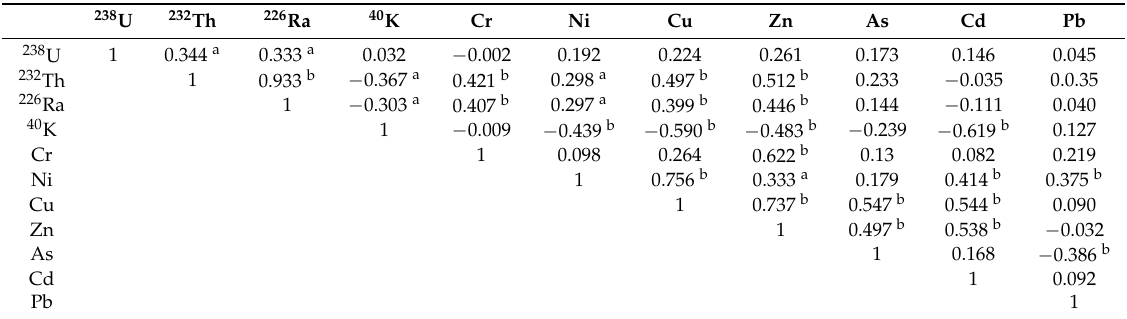
Table 6. The pearson correlation matrix for the natural radionuclides and the heavy